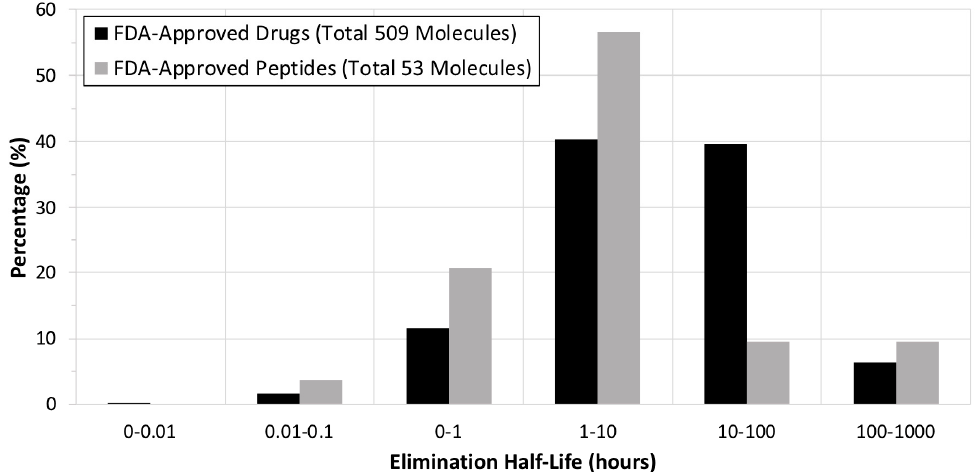
Figure 2. The elimination half-life (hours) of all FDA-approved drugs (509 validated molecules out of 555 molecules; black) and FDA-approved small peptides (54 validated molecules out of 57 molecules; gray). The FDA-approved drugs also include the FDA-approved small peptides. The FDA-approved small peptides are summarized in Table 1. The raw data (submission classification: Type 1—New Molecular Entity between January 1999 and December 2019) were collected from Drugs@FDA